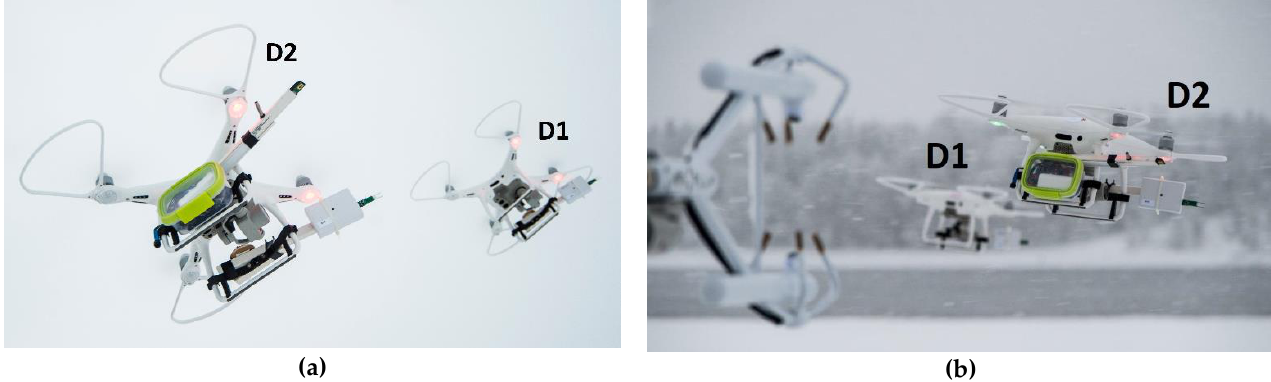
Figure 2. Two drones D1 and D2, equipped by meteorological sensors, used in the study ( a ). The photo in ( b ) shows the experiment when the drones were hovering near the acoustic anemometer.